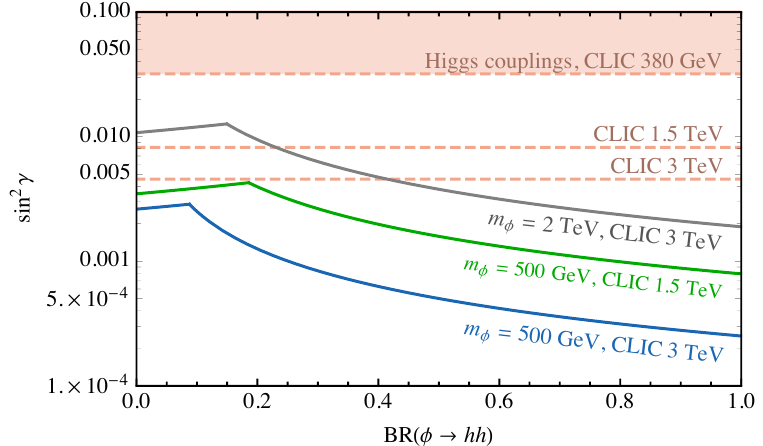
Figure 5. Dependence on BR (cid:30) ! hh of the combined direct reach in hh or V V at CLIC, compared with the sensitivity to sin (cid:13) expected from Higgs couplings measurements taken from ref. [49]. The green and blue lines are for m (cid:30) = 500 GeV at CLIC Stage II and III, respectively, the gray dashed line is for m (cid:30) = 2 TeV (at 3 TeV). The pink lines show the precision in Higgs couplings at the three CLIC stages.